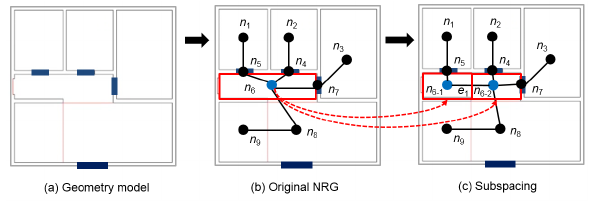
Figure 4. Sub-spacing example discussed in (Lee et al, 2014).